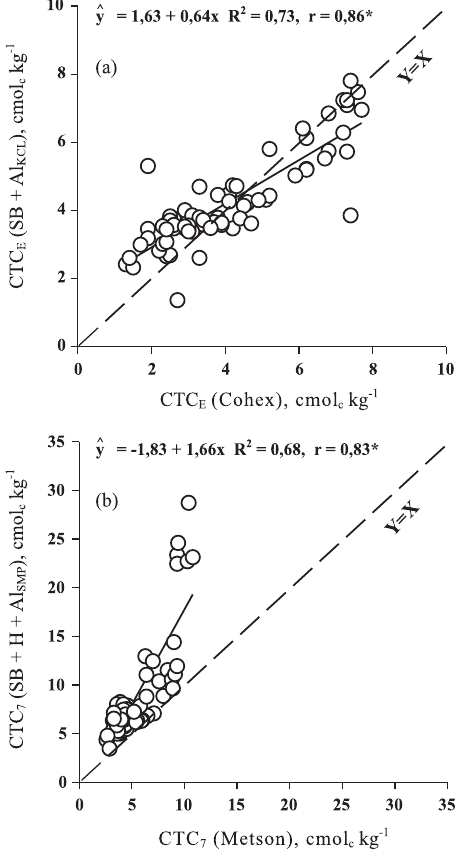
Figura 2. Relação entre (a) CTC efetiva e (b) CTC obtidas por diferentes métodos em 75 amostras de um Argissolo